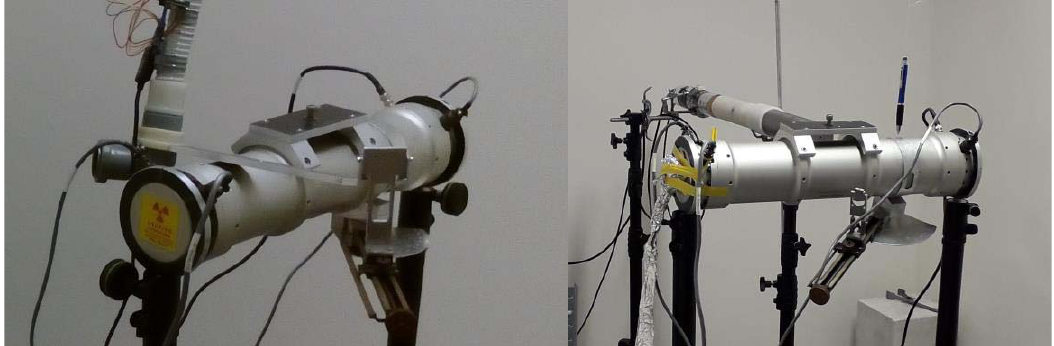
Figure 1. MP320 neutron generator with stilbene and diamond